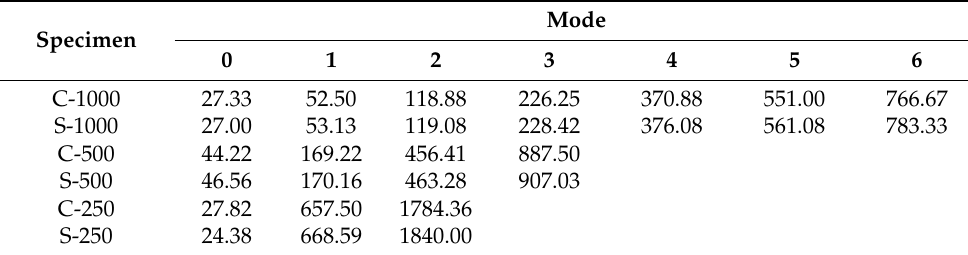
Table 11. Summary of identified frequencies ( in Hz ).